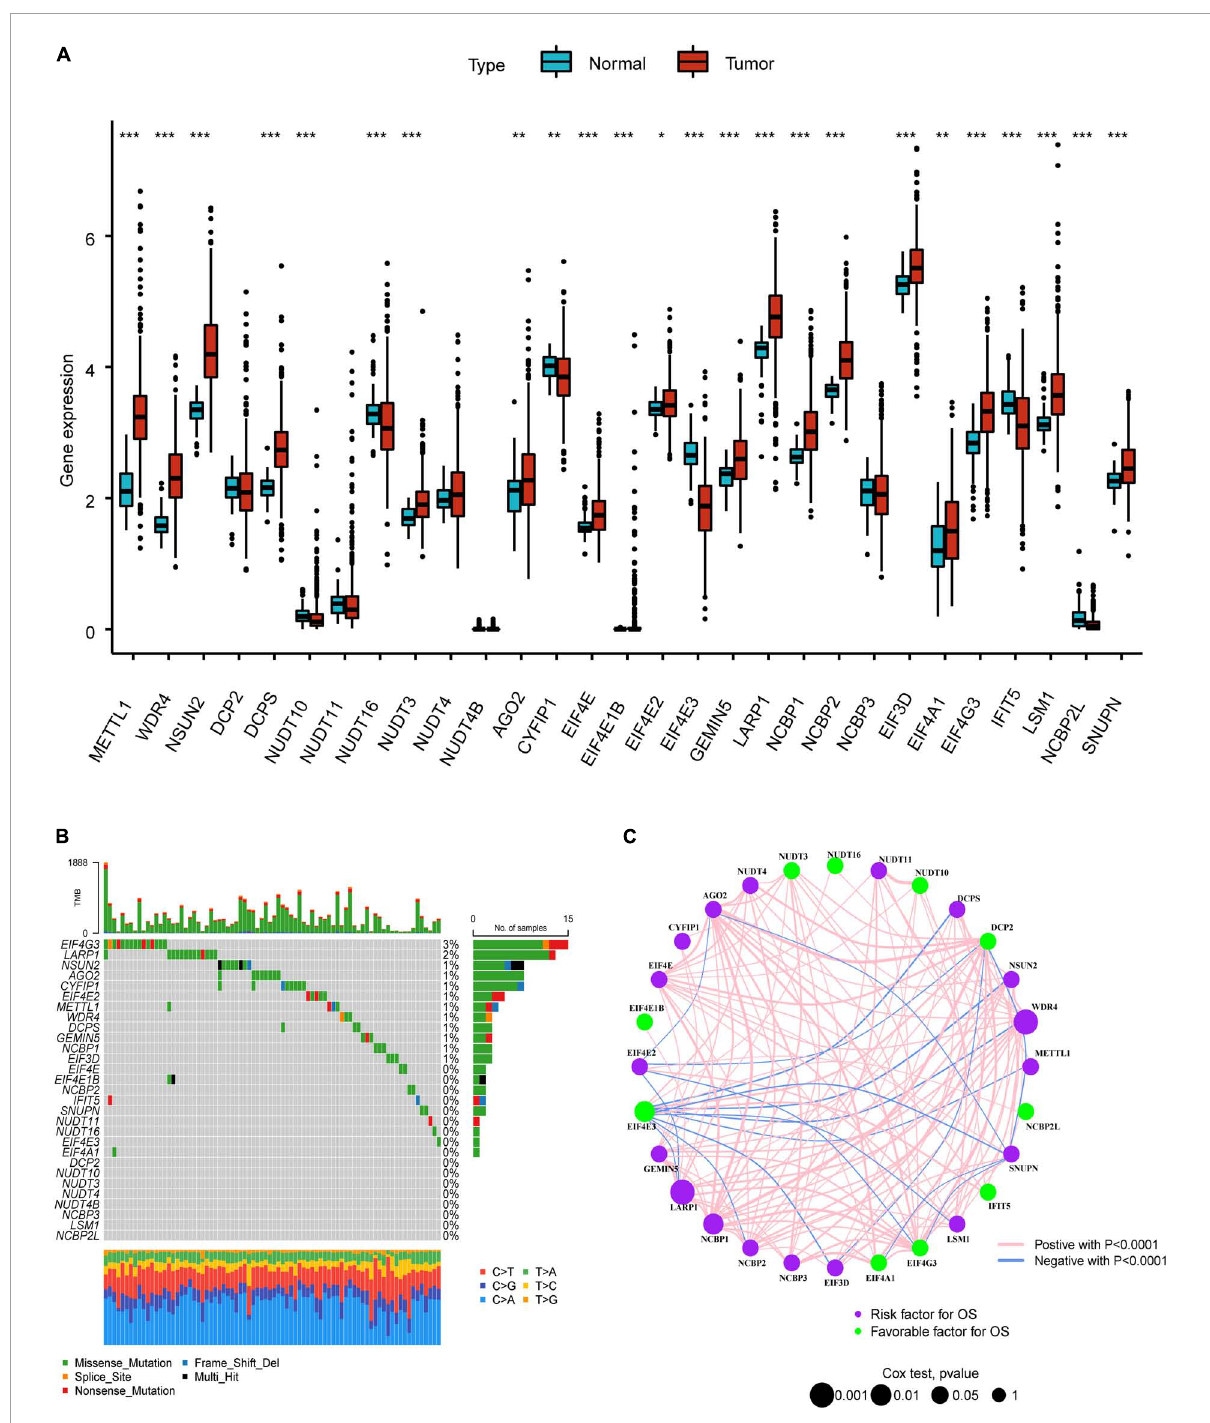
FIGURE2 Landscape of genetic variation in LUAD. (A) The difference of m 7 G regulators expression level in normal and tumor group. (B) The mutation map of m 7 G regulators in LUAD. (C) The interplay and prognostic significance of m 7 G regulators. * P < 0.05; ** P < 0.01; *** P < 0.001.